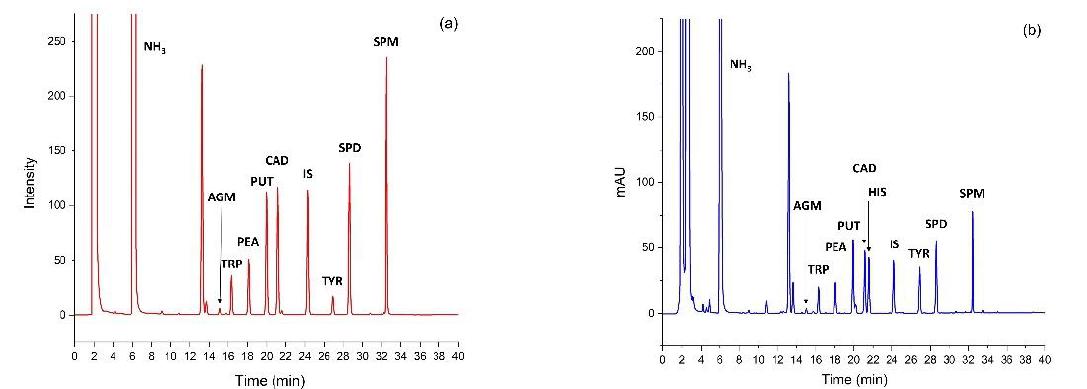
Figure 1. Chromatograms of the standard solution (11 mg / L) of the dansylated biogenic amines agmatine (AGM), tryptamine (TRP), phenethylamine (PHE), putrescine (PUT), cadaverine (CAD), histamine (HIS), 1,7-diaminoheptane (IS), tyramine (TYR), spermidine (SPD), and spermine (SPM). ( a ) fluorescence detector (350 / 520 nm) and ( b ) UV–vis (254 nm).